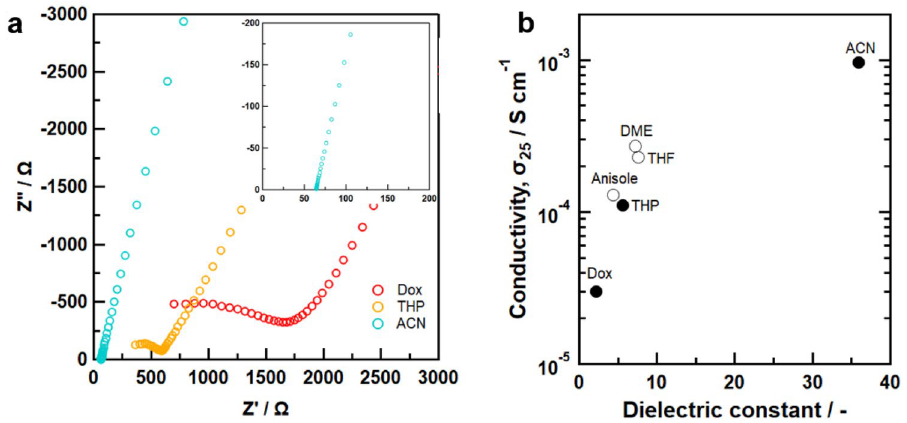
Figure 5. ( a ) Nyquist plot and ( b ) ionic conductivity at room temperature for 70Li 2 S–30P 2 S 5 system formed via Dox, THP, and ACN solvents as a function of dielectric constant together with those of 70Li 2 S–30P 2 S 5 system formed via other solvents 12–14 . The white circles indicate reference